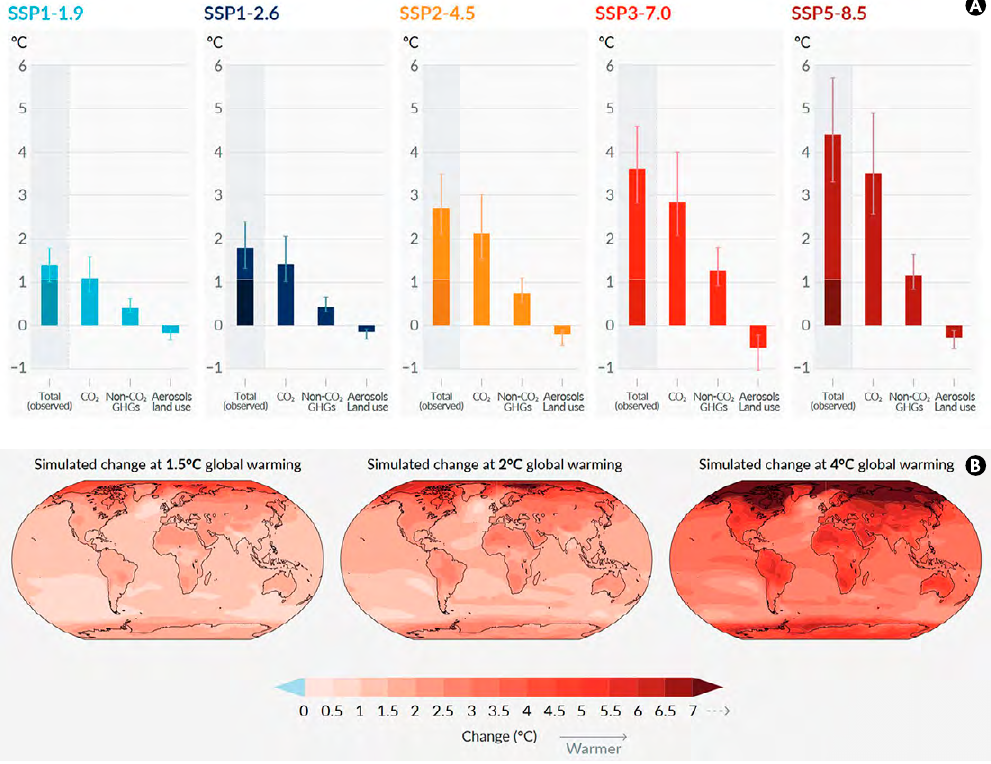
SSP scenarios based on different CO2 and GHG emission levels (SSP1-1.9, SSP1-2.6 – very low and low, SSP2-4.5 – intermediate, SSP3-7.0, SSP5-8.5 – high and very high emissions); B) Spatial distribution of the global annual